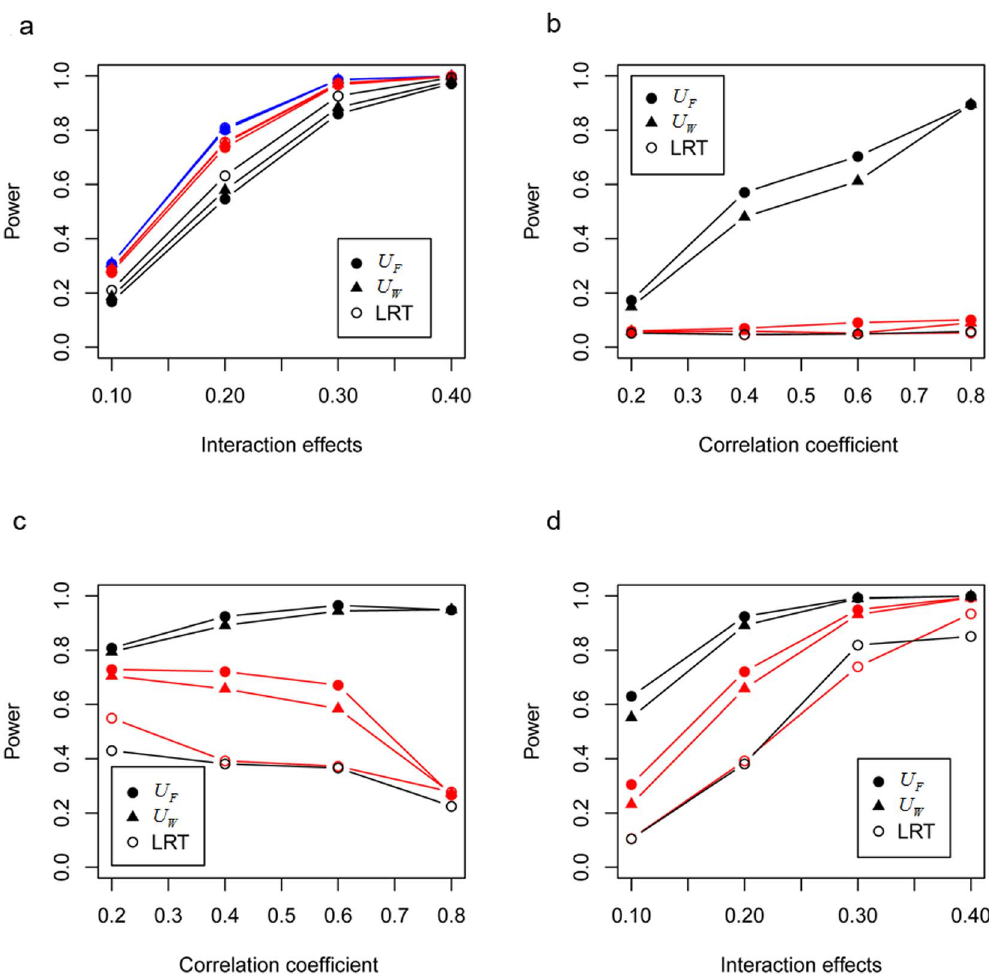
Figure 2. Simulations for clarifying the relationship between co-association and interaction. a for Type I co-association; b for Type II co- association; c for Type III co-association given fixed interaction effect 0.2 and different correlation; d for Type III co-association given fixed correlation 0.4 and different interaction effects. The case with no main effects ( b 1 ~ b 2 ~ 0 ), one main effects ( b 1 ~ 0 , b 2 ~ log(1 : 3) ) and two main effects ( b 1 ~ log(1 : 5) , b 2 ~ log(1 : 3) ) are shown by blue, red and black lines respectively.